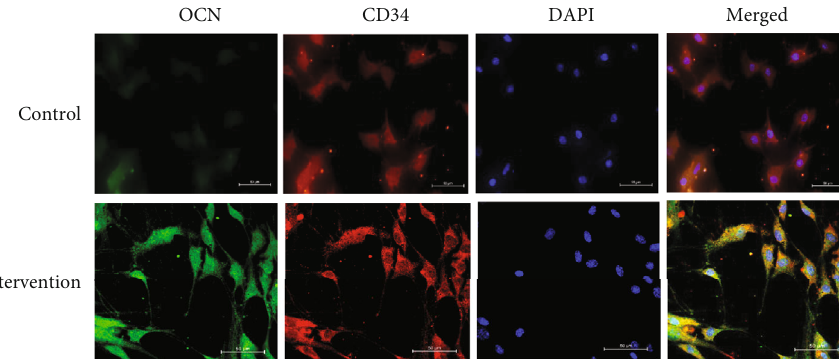
Figure 3: Immunostaining for OCN and CD34 in the control group (untreated cells) and AGE- and β -glycerophosphate-induced EPCs. OCN (green) and CD34 (red) protein levels were notable in EPCs exposed to AGE for 7 days. Nuclei were stained with DAPI (blue). Merged images show colocalization of staining for OCN and CD34. Magni fi cation, × 400. AGE: advanced glycation end product; EPC: endothelial progenitor cell; OCN: